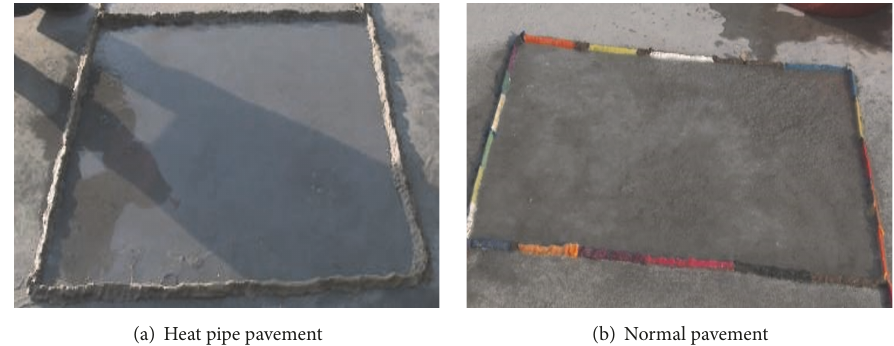
Figure 11: Antifreezing performance of heat pipe pavement on 10 February 2016.